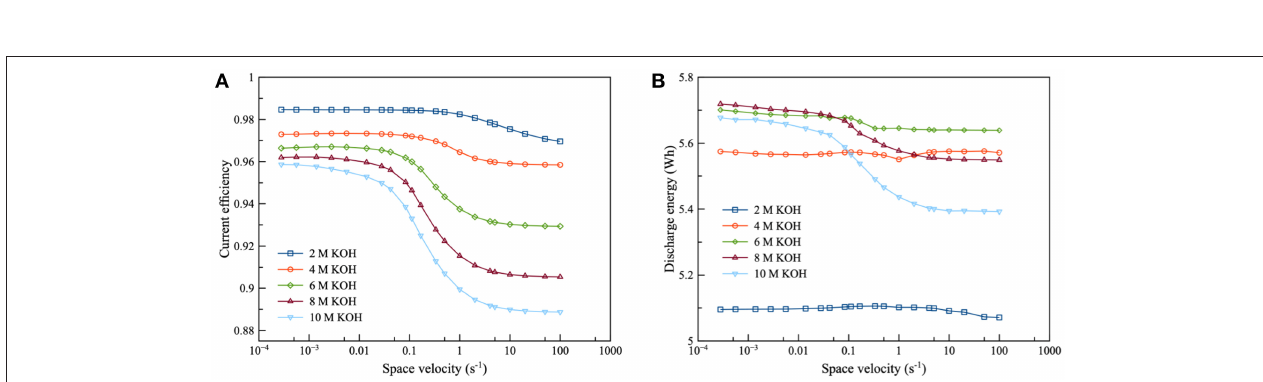
FIGURE 3 | Validation of the proposed models: (A) polarization characteristic of ZAFB (B) anode and cathode overpotential of ZAFB (C) polarization characteristic of Zn electrolyzer and (D) anode and cathode overpotential of Zn electrolyzer.